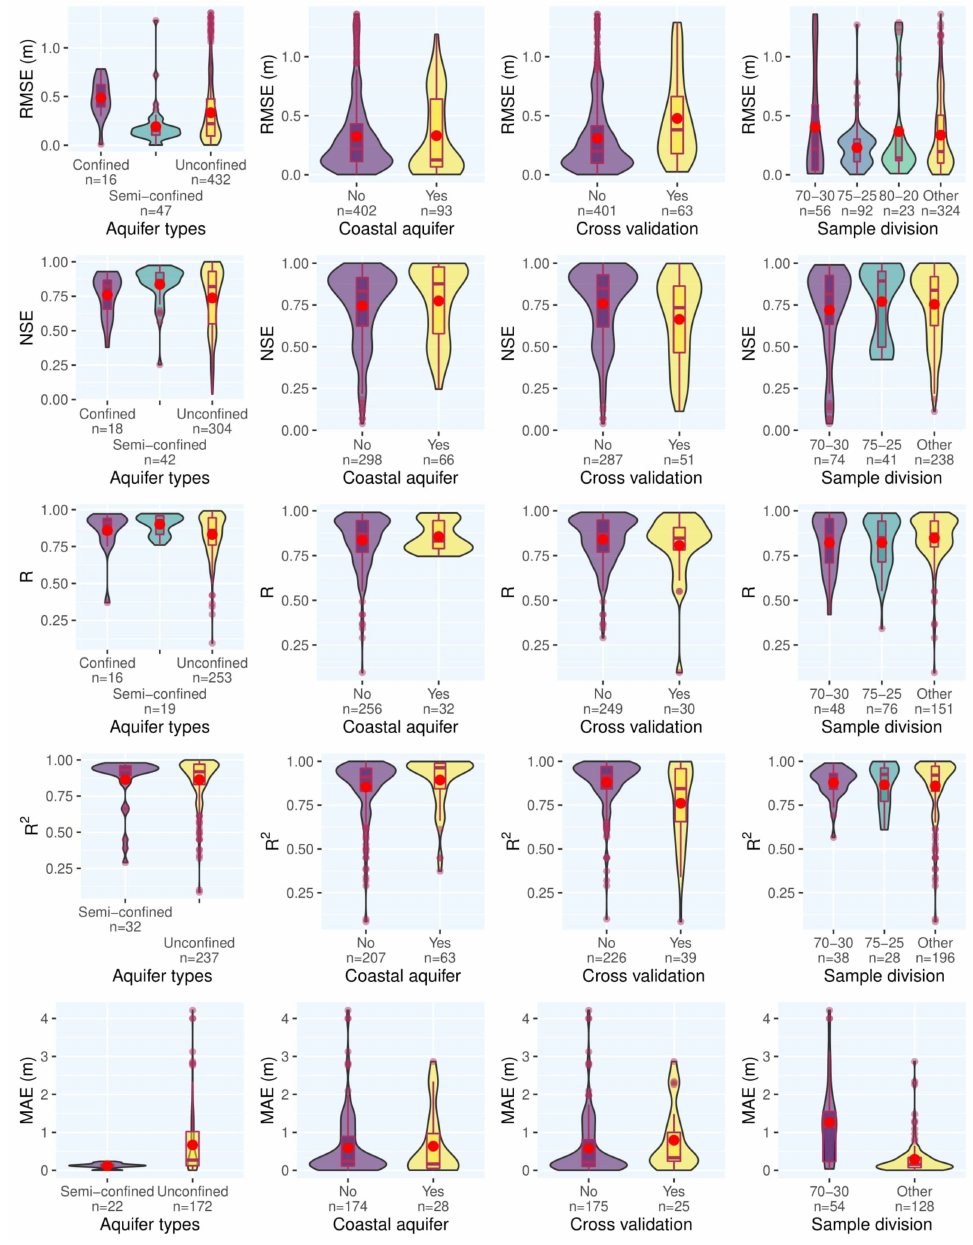
Figure 14. Meta-analysis results according to various subcategories in the reviewed